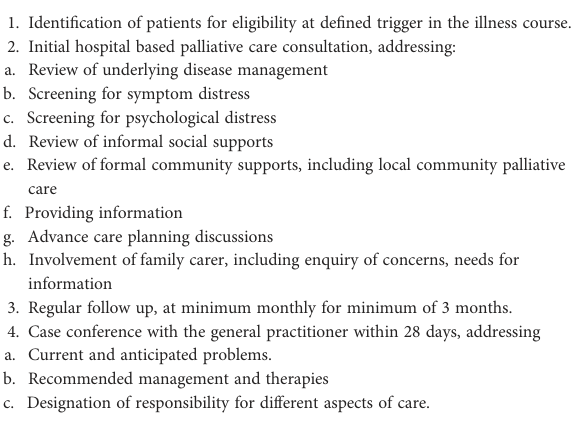
TABLE 2 Key components of STEP Care